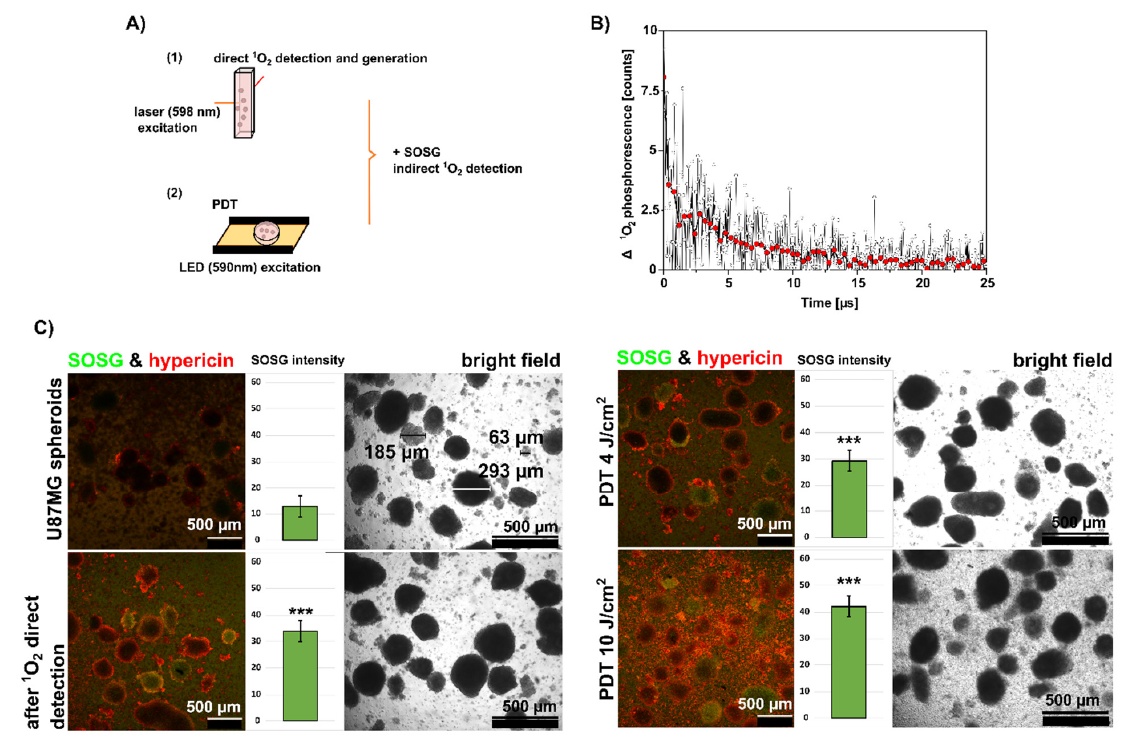
Figure 4. ( A ) Schematic illustration of the approaches used for the generation of 1 O 2 (1 and 2) and the detection of 1 O 2 by direct and indirect methods. ( B ) Difference in 1 O 2 phosphorescence in cells with and without 5 µM hypericin detected by the direct approach (1st in A ). Raw data are presented in black, and mean values in red. ( C ) Bright field and fluorescence microscopical images of U87MG cells that spontaneously formed spheroids with 500 nM hypericin (red fluorescence), before and after direct 1 O 2 detection and after irradiation with 590 nm at 4 and 10 J/cm 2 (generation of 1 O 2 with the second approach shown in ( A ). Scale bar represents 500 µm. Singlet Oxygen Sensor Green (SOSG) was used to detect 1 O 2 production in the cells (green fluorescence). The green histograms in the insets show the mean SOSG intensity determined from the fluorescence images. Experiments were performed in duplicate. The degree of significant difference was analysed using the one-way method ANOVA, *** p < 0.001.